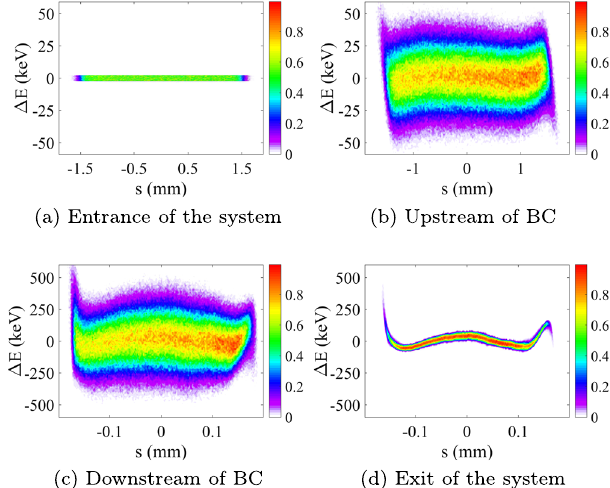
FIG. 2. Longitudinal phase space (slice energy spread) with energy chirp removed: (a) at the entrance of the reversible system, upstream of the first linac, (b) upstream of the bunch compressor, (c) downstream of the bunch compressor, upstream of the second TGU, (d) at the exit of the system, downstream of the second TGU. Energy chirp is removed up to the second order, and the bunch head is on the right-hand